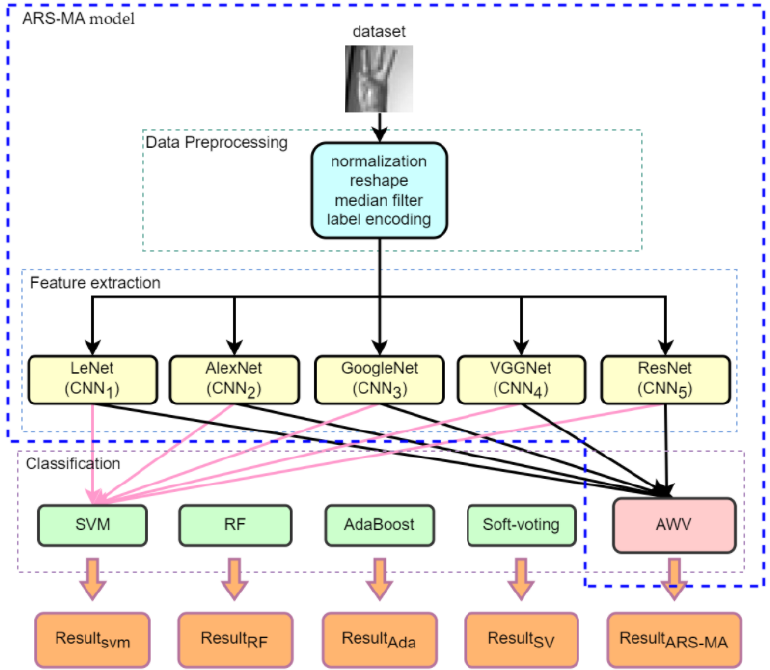
Figure 2. The proposed model schematic.